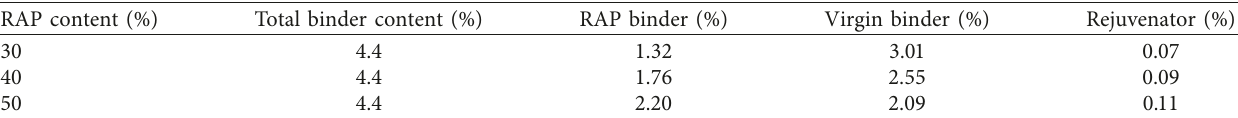
Table 10: The binder composition in